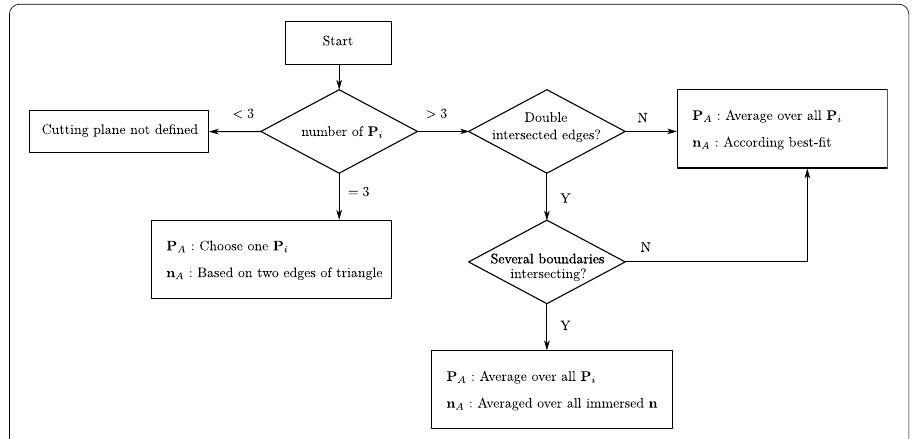
Fig. 22 Strategy to determine the cutting plane for a given intersected background element. Determination requires a base point P A and a normal vector n . P i denotes the intersection